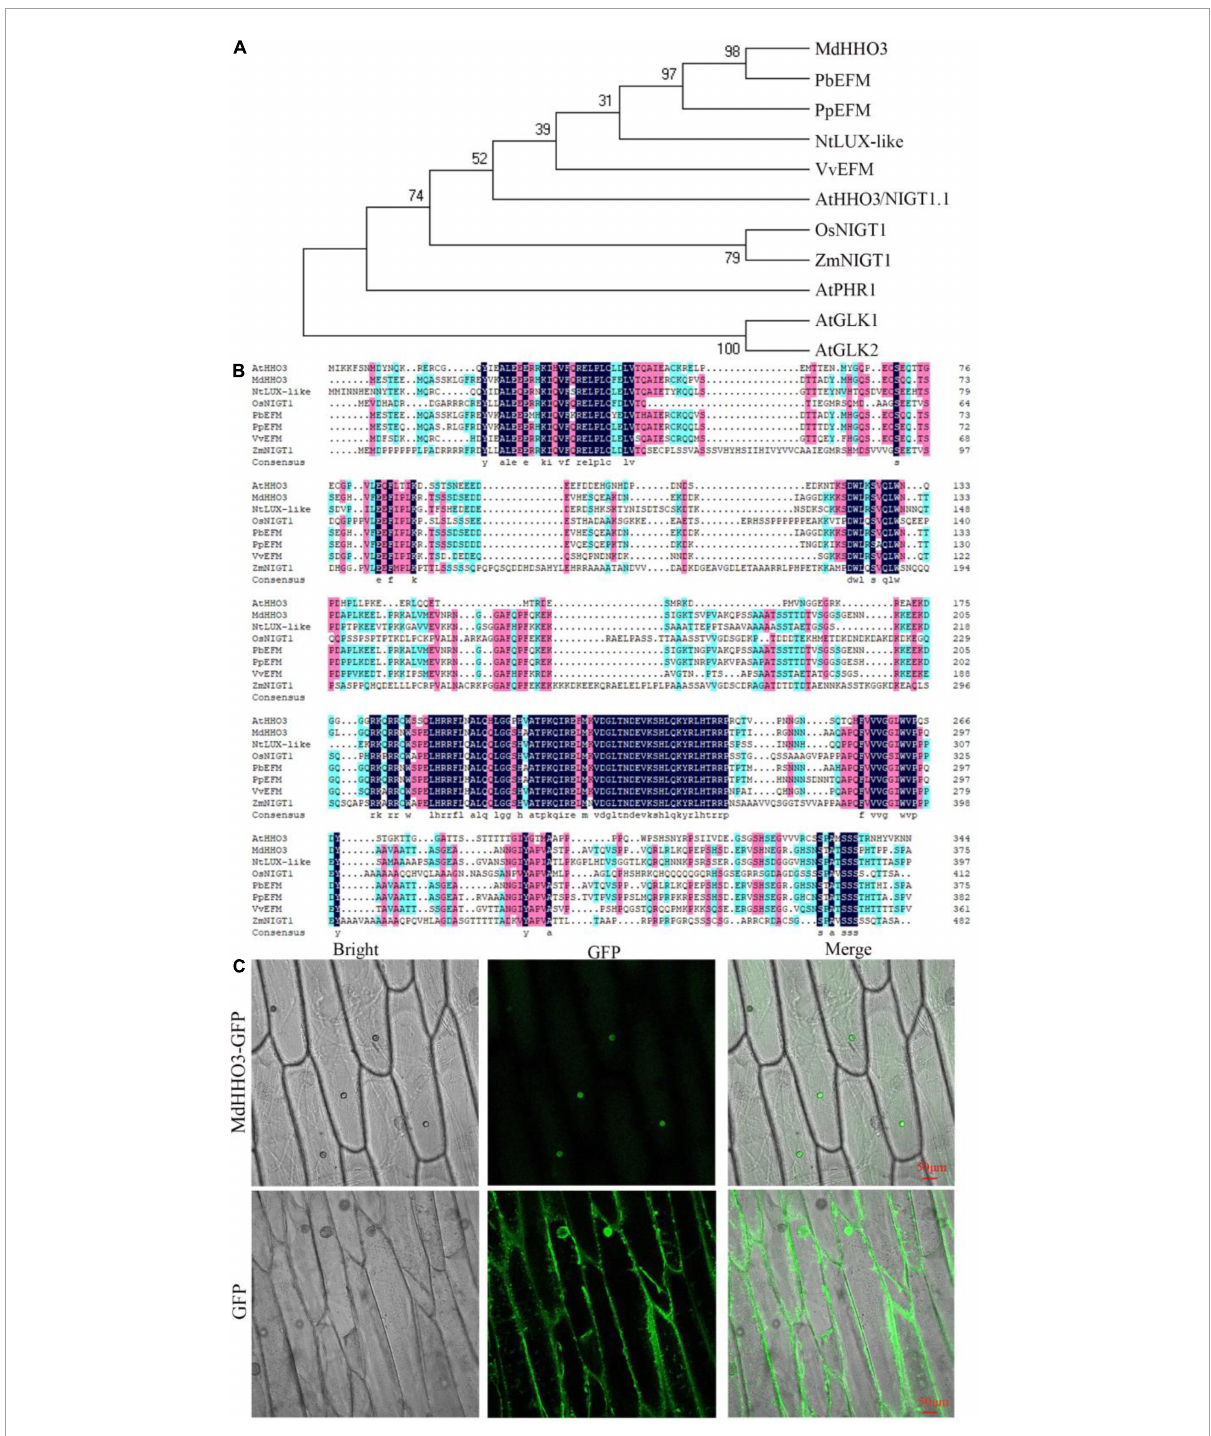
FIGURE2 Phylogenetic analysis and subcellular localization of MdHHO3. (A) Phylogenetic tree analysis of HHOs of different species. The protein sequences of HHOs are listed in Supplementary Table 2 . (B) Sequence alignment of 8 HHOs proteins. PbEFM (XP_009336613.1) in white pear ( Pyrus bretschneideri ), PpEFM (XP_007223224.2) in peach ( Prunus persica ), NtLUX-like (LUX ARRHYTHMO-like XP_016469710.1) in tobacco ( Nicotiana tabacum ), VvHHO3-like (AUZ62361.1) in grape ( Vitis vinifera ), AtHHO3/NIGT1.1 (NP_564236.1) in Arabidopsis thaliana , OsNIGT1 (XP_015623779.1) in rice ( Oryza sativa ), and ZmNIGT1 (PWZ44894.1) in maize ( Zea mays ) were used in the phylogenetic tree and sequence alignment analyses. (C) Subcellular localization of the 35S:MdHHO3-GFP fusion protein in onion; 35S: GFP was used as the control. GFP represents a green fluorescent